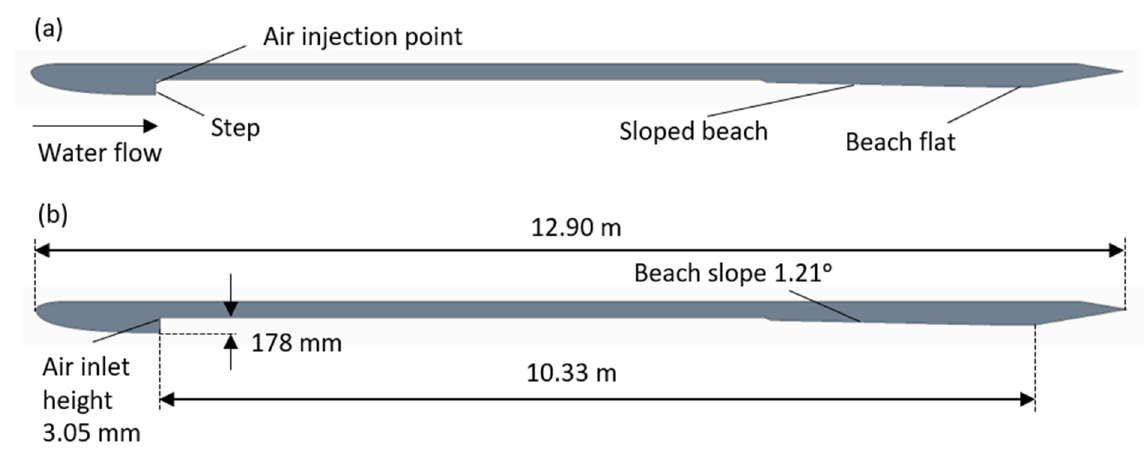
Figure 2. ( a ) Geometry and ( b ) dimensions of body with recess on the lower side.